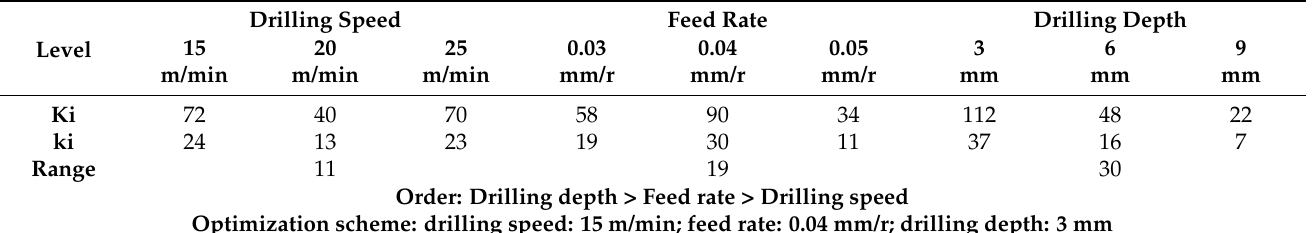
Table 8. Range analysis of bit service